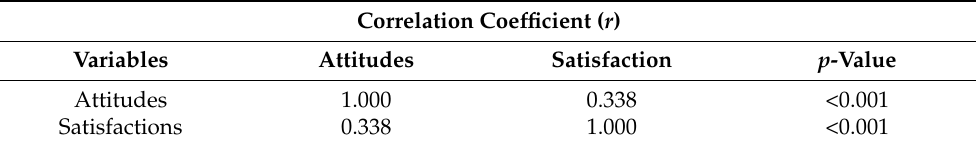
Table 4. Spearman correlation analysis of attitude and satisfaction